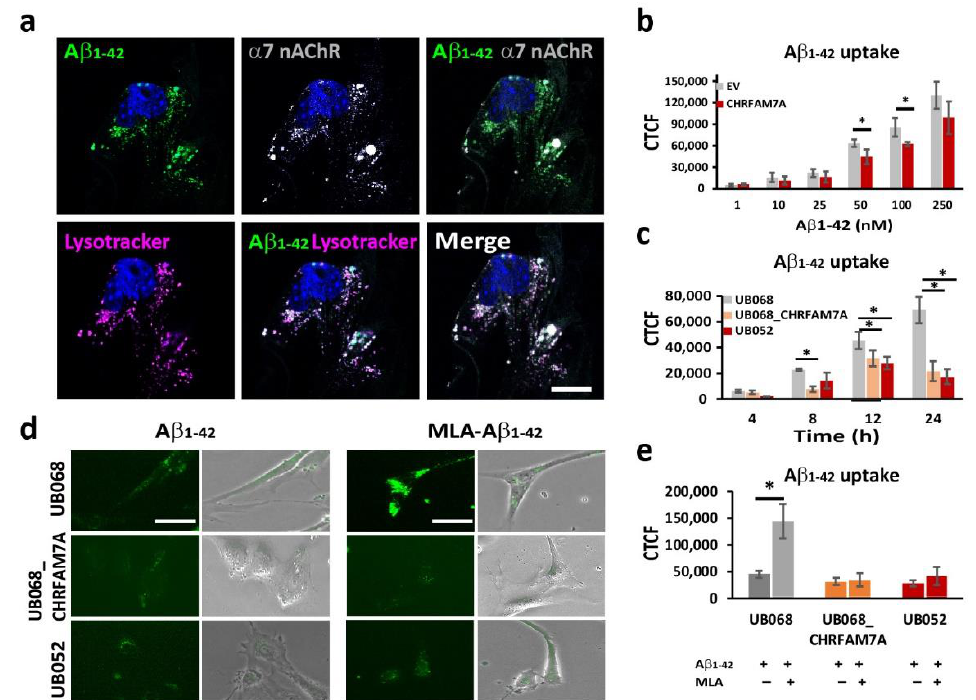
Figure 2. CHRFAM7A mitigated the α 7-nAChR-dependent A β 1–42 uptake: ( a ) Confocal microscopy images demonstrated the localization of A β 1–42 (green), LysoTracker Deep Red (magenta), and α 7 nAChR (grey) in MGL cells derived from the UB068 line. Nuclei were stained with DAPI (blue). The uptake of A β 1–42 co-occurs with LysoTracker and α 7 nAChR. Scale bar, 10 µ m. Cells were incubated with A β 1–42 (100 nM) for 24 h, then washed and incubated with LysoTracker for 5 h ( n = 5; three independent cultures). ( b ) Transfection of the MGL cells derived from UB068 line (0